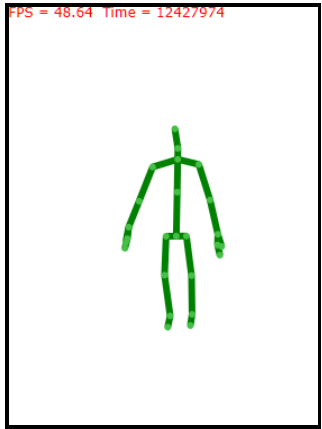
Figure 12. Skeleton from Kinect Animation Studio